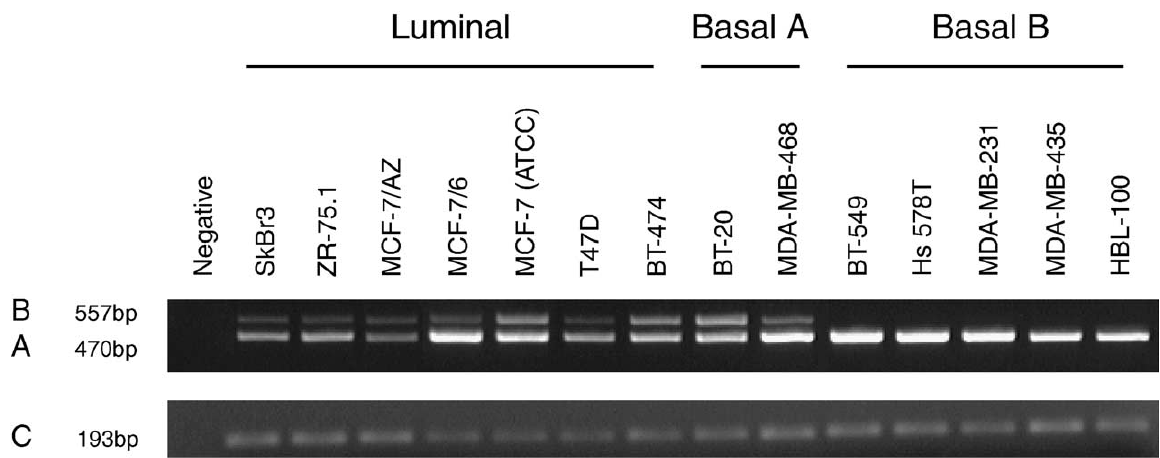
Fig. 3. Expression of p120ctn isoforms type 1, 2 and 3 mRNAs in breast cancer cell lines, analysed by RT-PCR. Numeric isoform codes and their fragment sizes are depicted on the left.